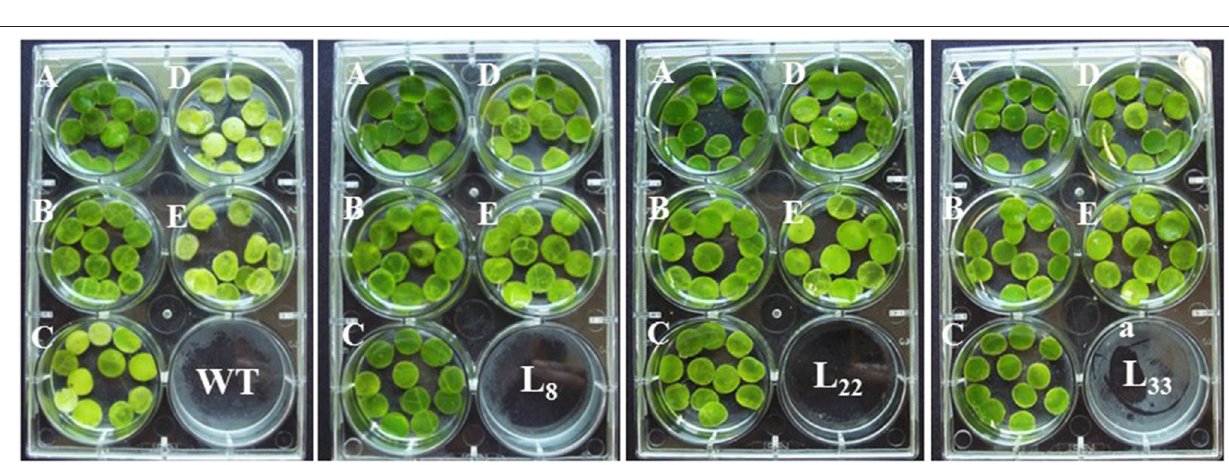
lines maintained quite higher E than WT ( Figure 8D